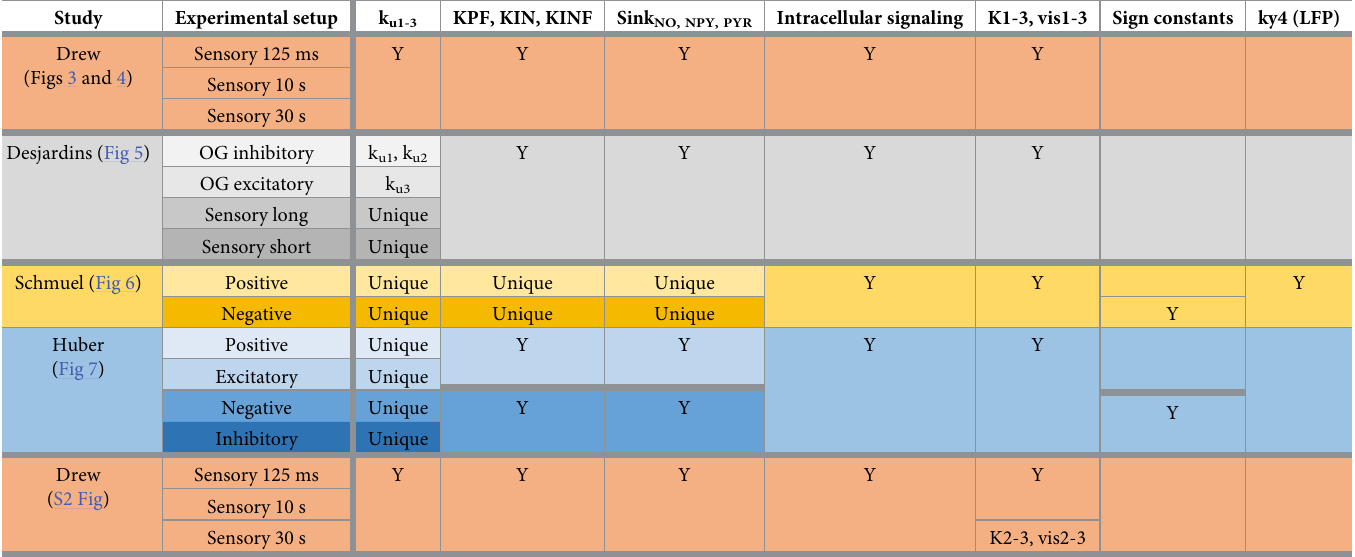
Table 1. Overview of parameter usage over all experimental setups. Study Experimental setup